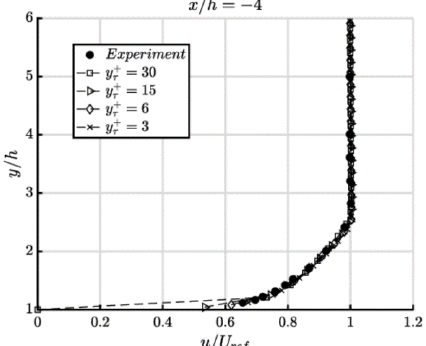
Figure 4. Streamwise velocity distributions at the location x/h = - 4 as the function of normalized wall distance, y . The velocity was normalized by the reference velocity, U ref , defined in Reference [50] for each simulation.